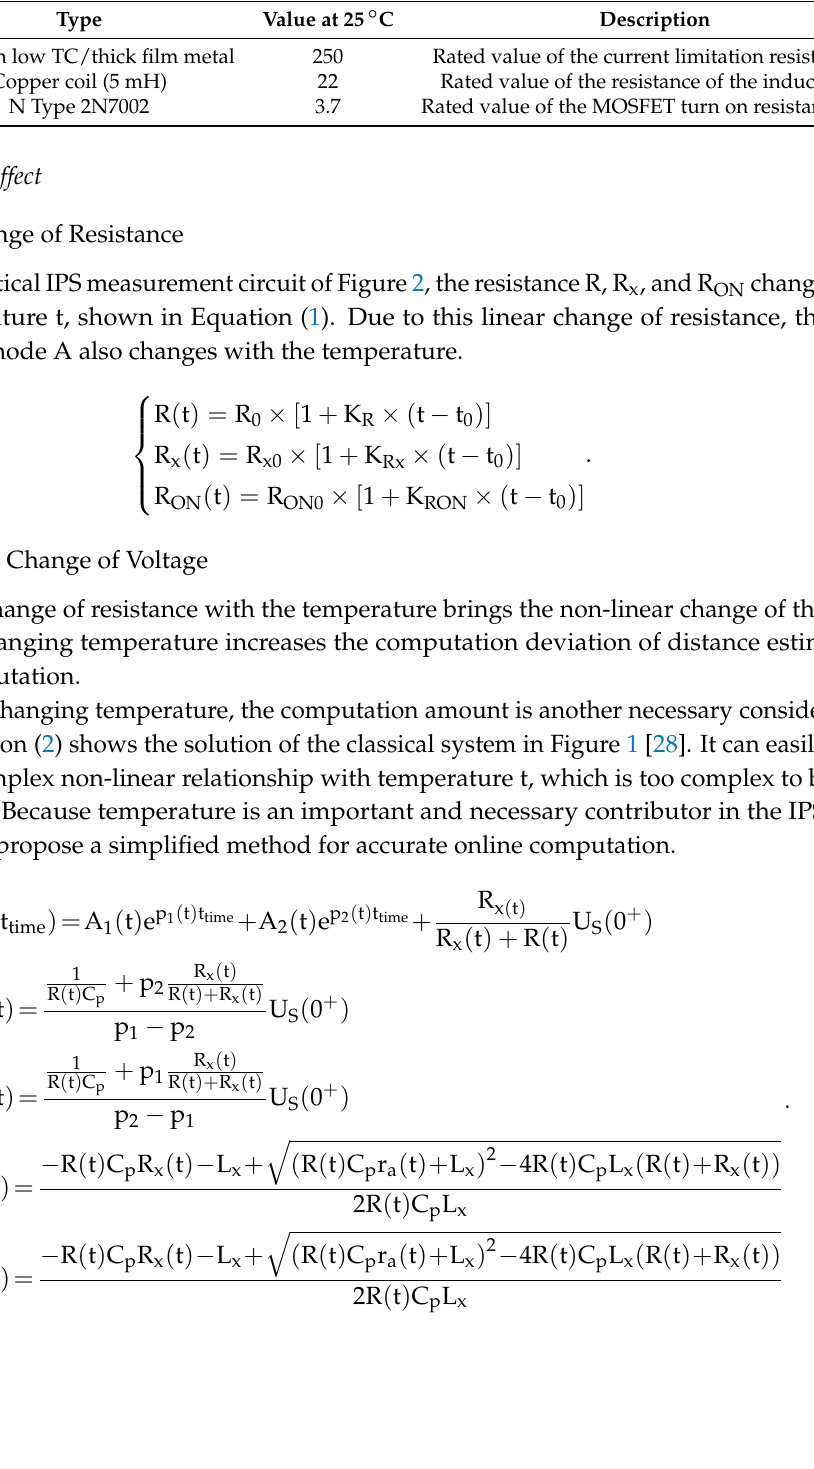
Table 2. Typical resistance